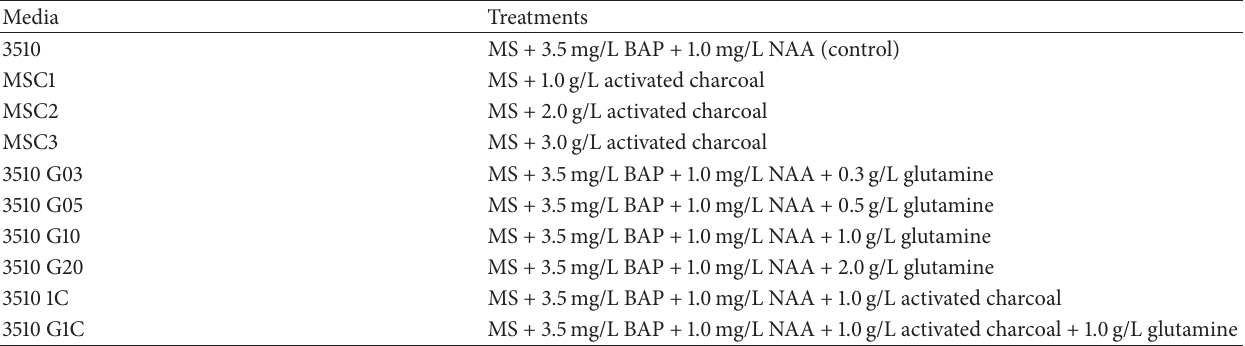
Table 6: Modification of multiplication media with different concentrations of activated charcoal and glutamine.